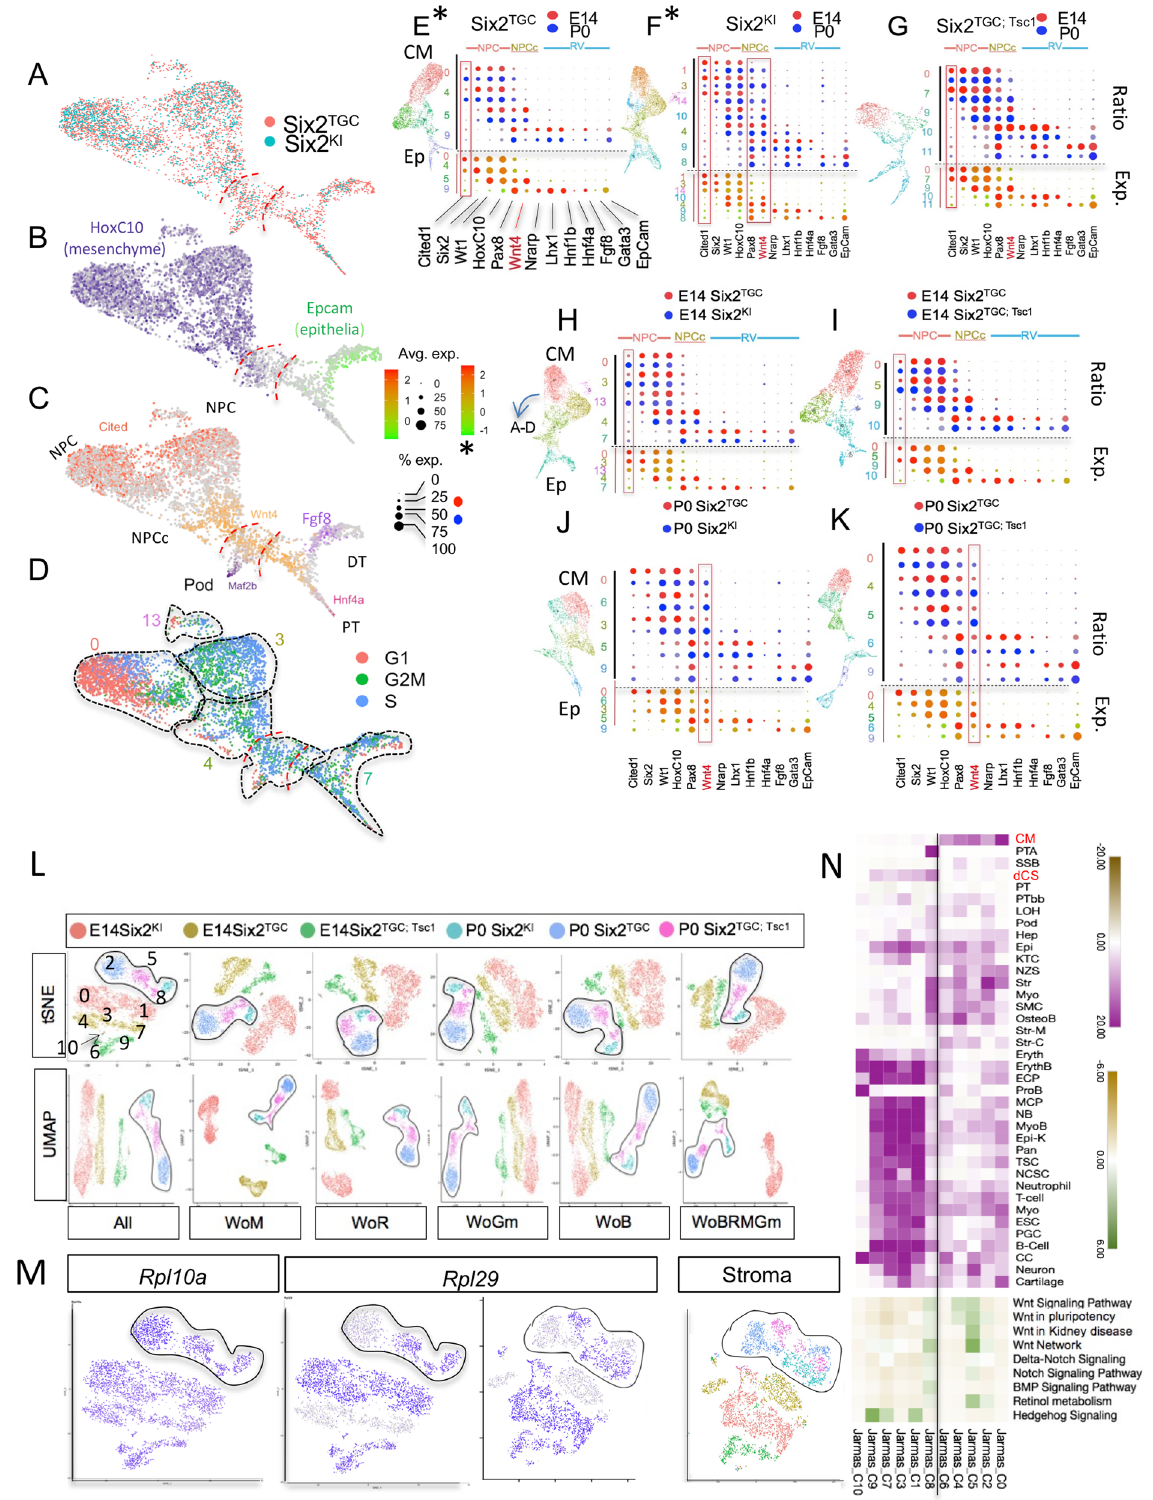
top term distinguishing Six2 TGC;Tsc1 NPC from control at P0 was respiratory electron transport and heat production by uncoupling proteins (Supplementary Data 7 and Supplementary Fig. S1I). By this measure, Six2 TGC;Tsc1 NPC clusters appear older than Six2 TGC . The emergence of ribosomal and metabolic signatures is consistent with the involvement of the mTOR signaling